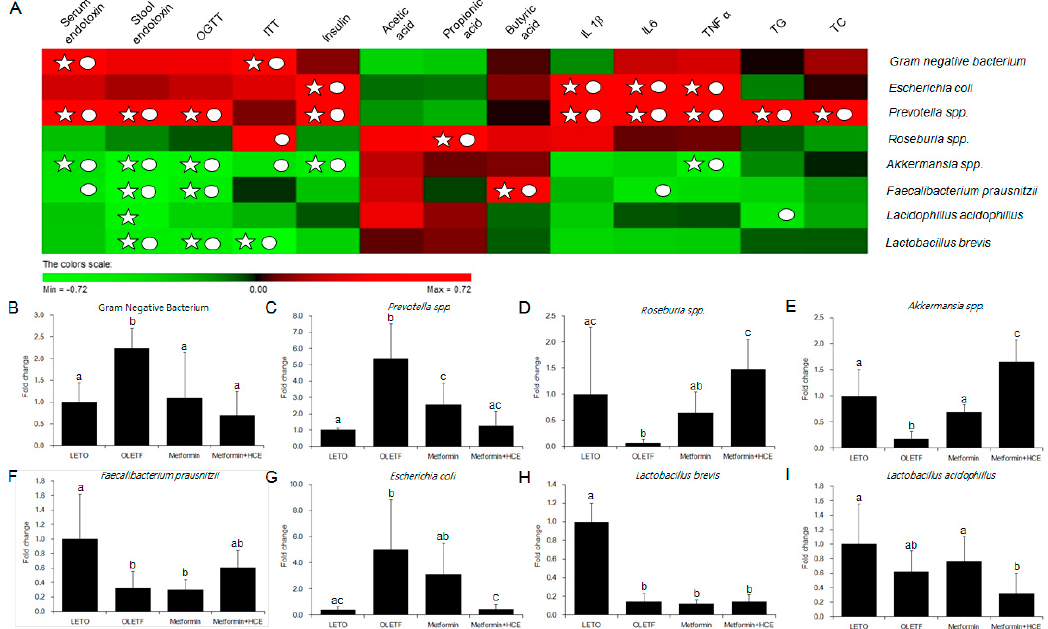
Figure 8. Relative abundance of gut microbiota and correlation between gut microbial relative abundance and host parameters. ( A ) The correlation analysis was performed using two-tailed Pearson’s correlation test and diagramed by PermuMatrix software (version 1.9.3 EN) using heatmap plots; ( B – I ) R value greater than 0.4 indicates a positive correlation (red color), while r value less than − 0.4 indicates a negative correlation (green color). A symbol of ○ indicates value of Pearson r > 0.4 or r < − 0.4 and a symbol of ☆ indicates statistical significance of p value less than 0.05. The relative abundance of the 16S rRNA gene of the gut bacteria in stool samples was determined using real-time PCR as described in the Materials and Methods section. The results are expressed as normalized fold values relative to the normal group. Data are expressed as the mean ± SD ( n = 7). Data with different letters are significantly different ( p < 0.05) according to one way ANOVA analysis.